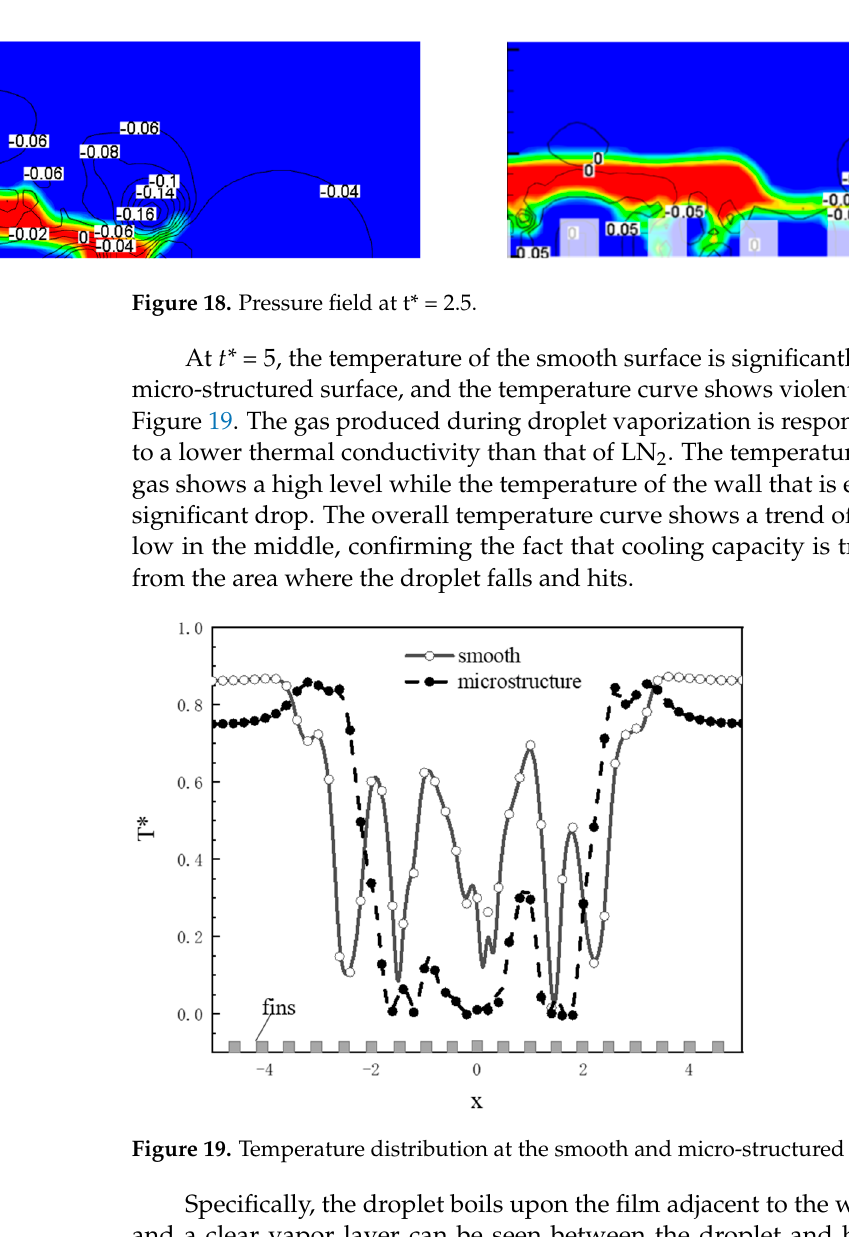
Figure 17. Variation in residual radius of vaporized droplet on the smooth and micro-structured surfaces, respectively.